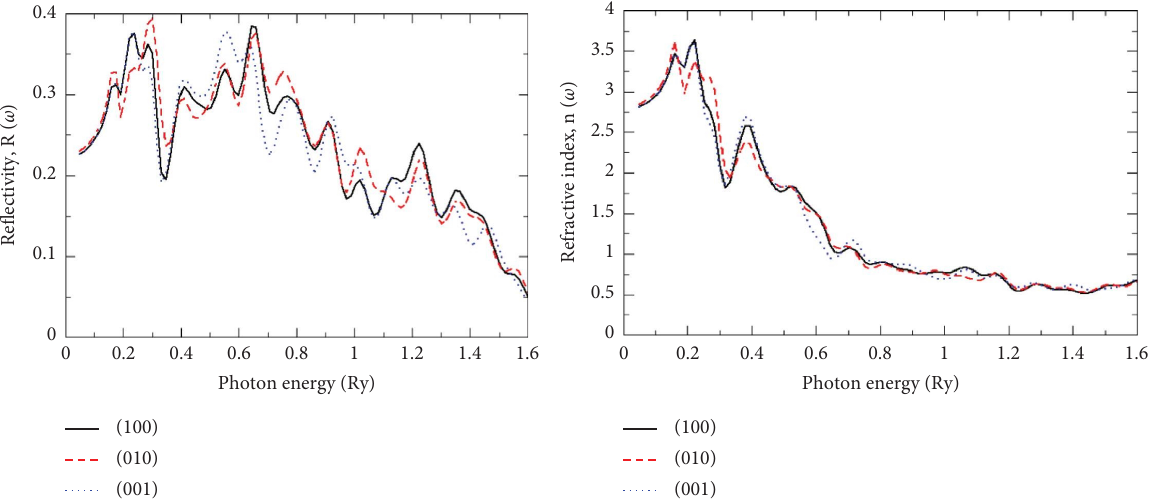
Figure 9: Te optical refectivity and refractive index of CaHfS